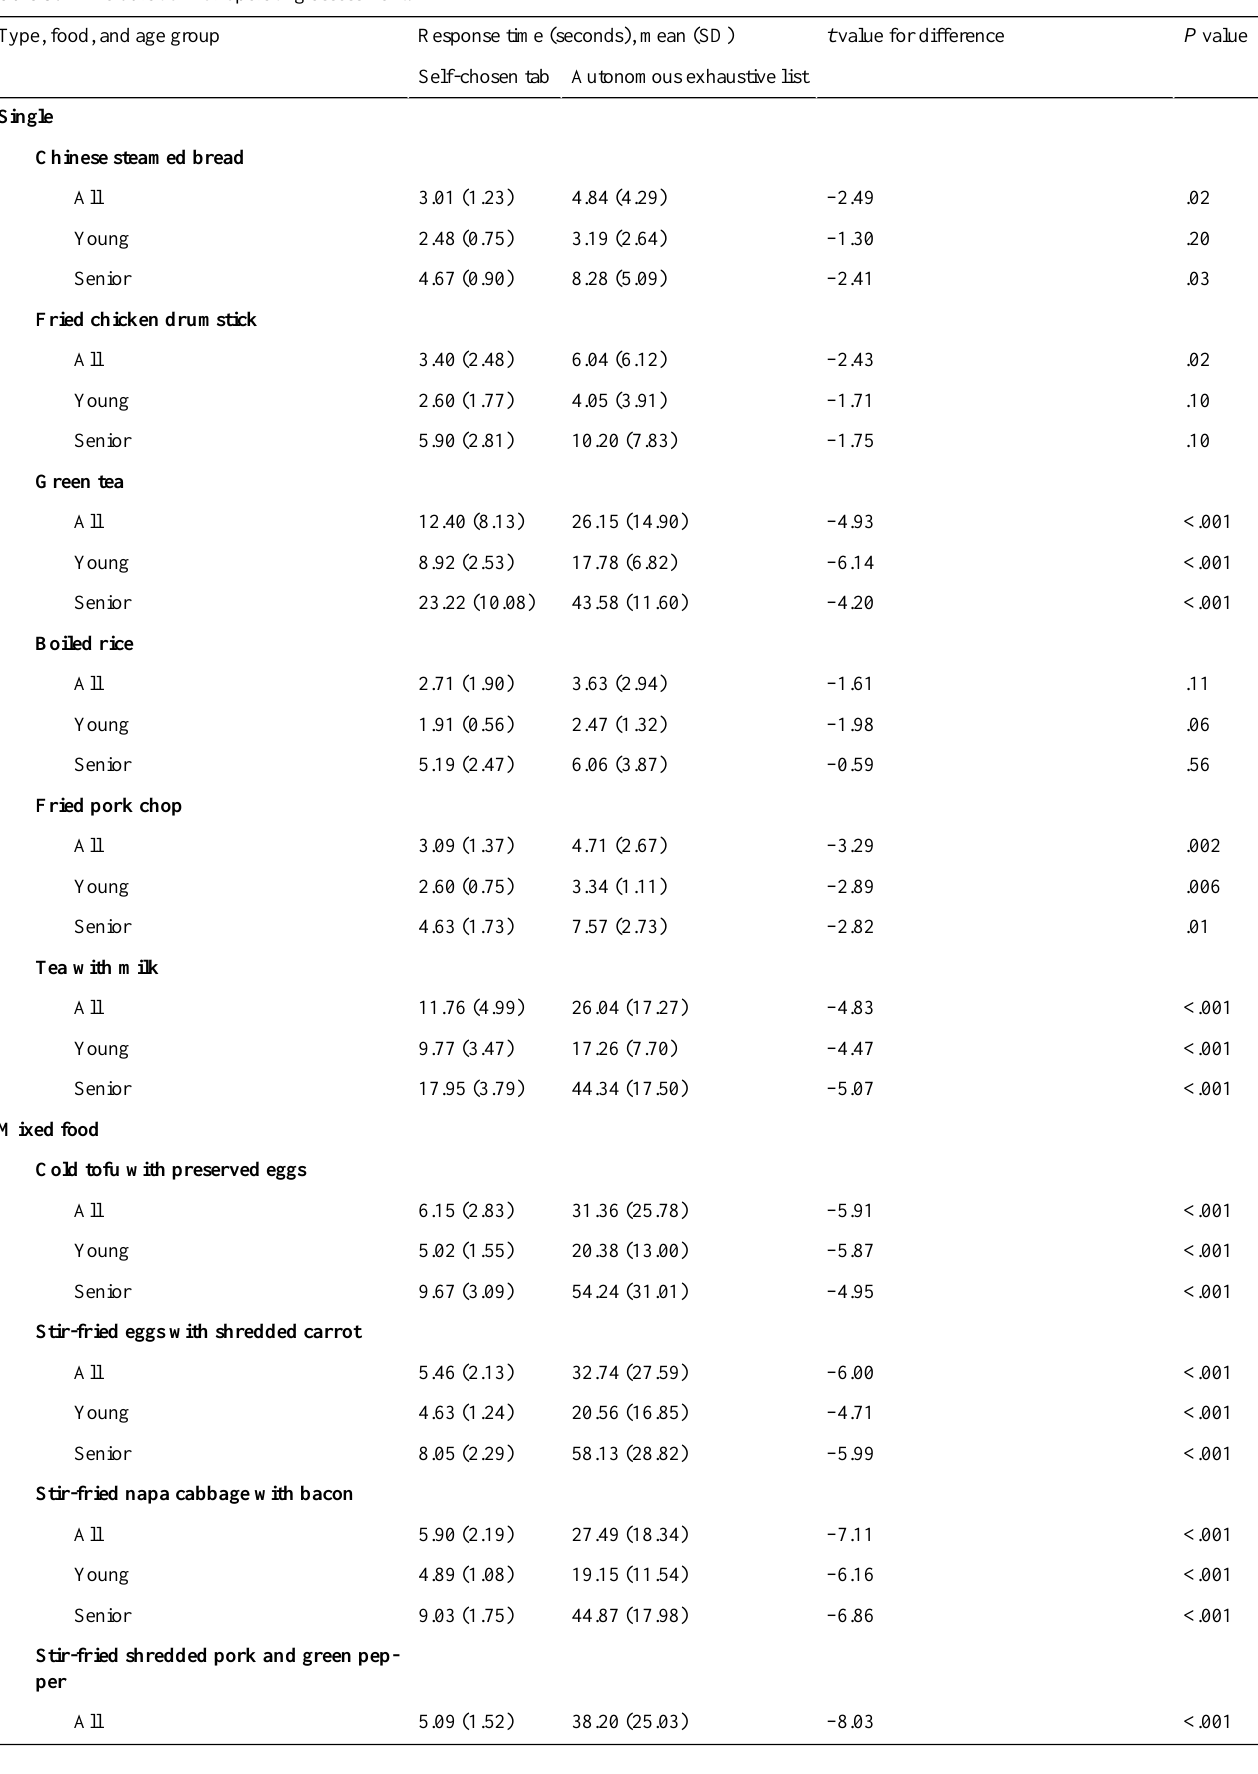
Table 3. Time duration for operating